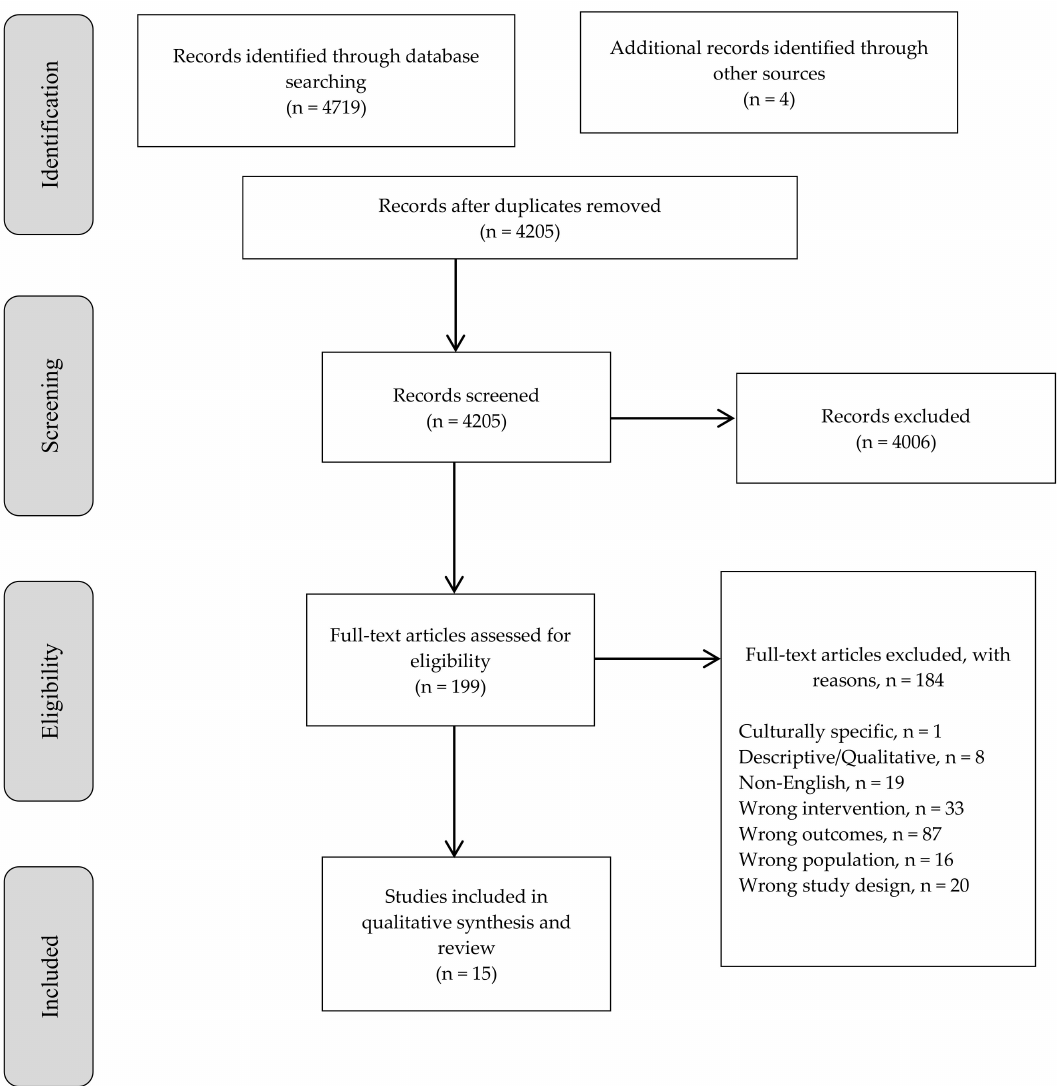
Figure 1. Flow diagram of studies included in